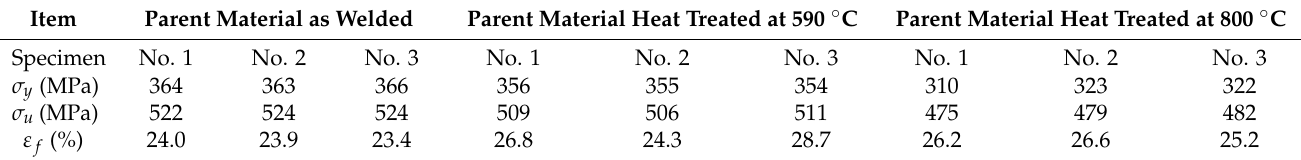
Table 1. Yield strength, tensile strength, and elongation rate of the parent material.